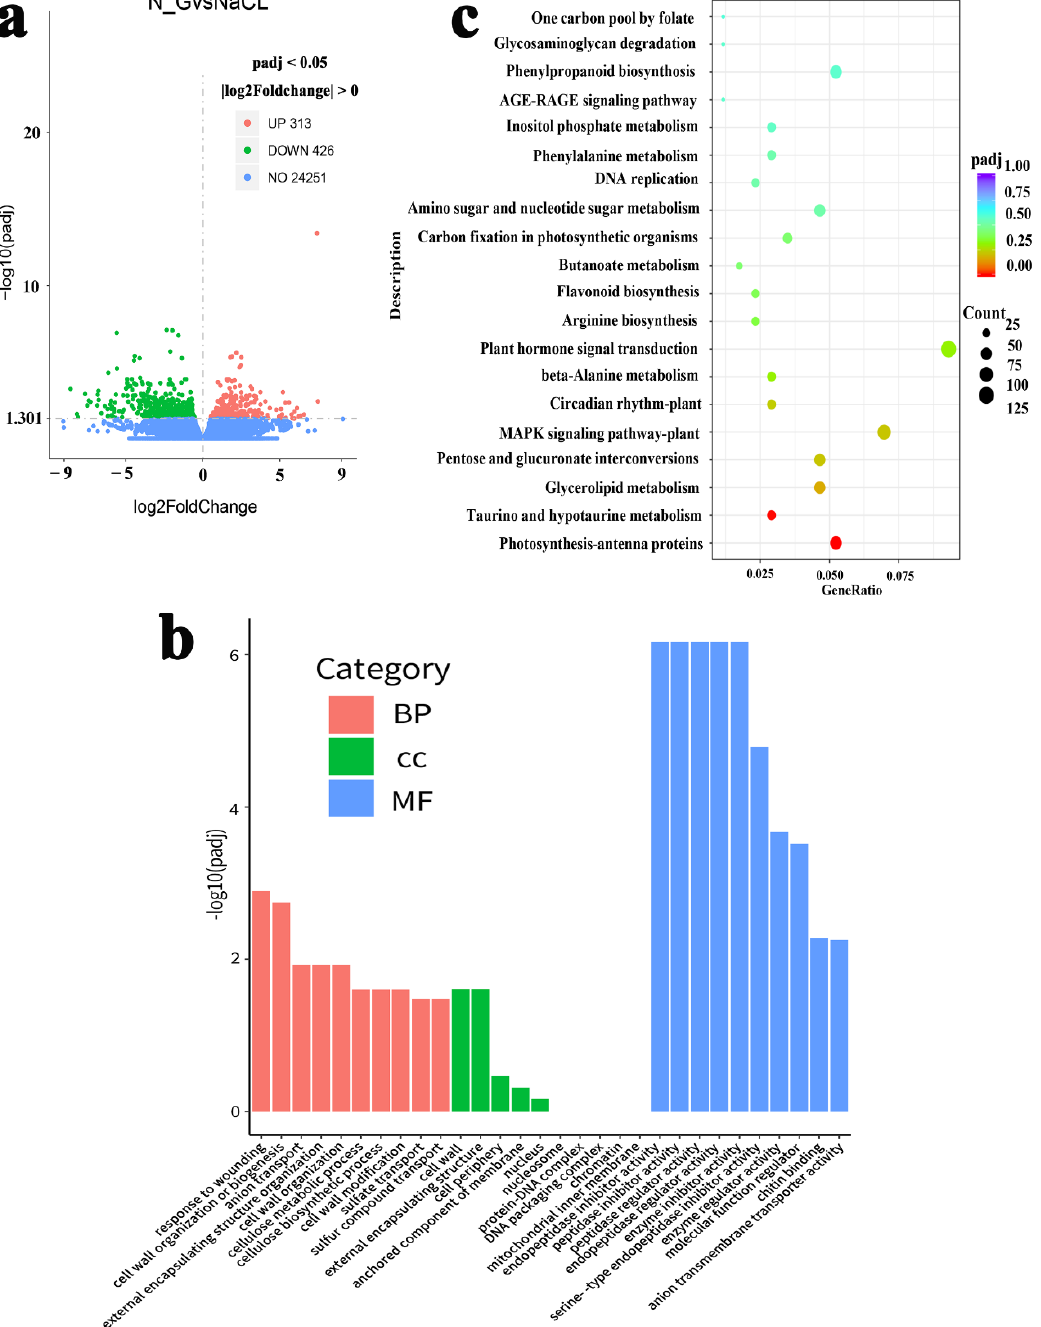
Figure 2. Transcriptome profiling analysis during NO alleviation of salt stress in tomato seedlings. ( a ) The number of DEGs is shown by the volcano plot. Red and green points represent up- and downregulated genes, respectively, and blue points represent no differences. ( b ) Functional gene ontology (GO) enrichment analysis of DEGs. GO terms are summarized in three categories: cellular component, molecular function, and biological process. ( c ) The DEG enrichment in different KEGG pathways. N_G: NaCl + GSNO; vs.: versus.